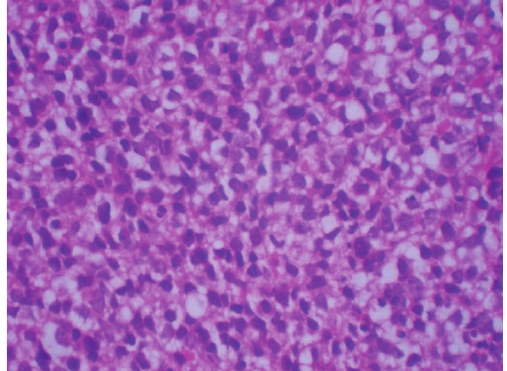
Figure 7: Histopathological picture showing sheets of neoplastic cells having round hyper chromatic nuclei with scanty discernible cytoplasm. Some cells have clear cytoplasm.